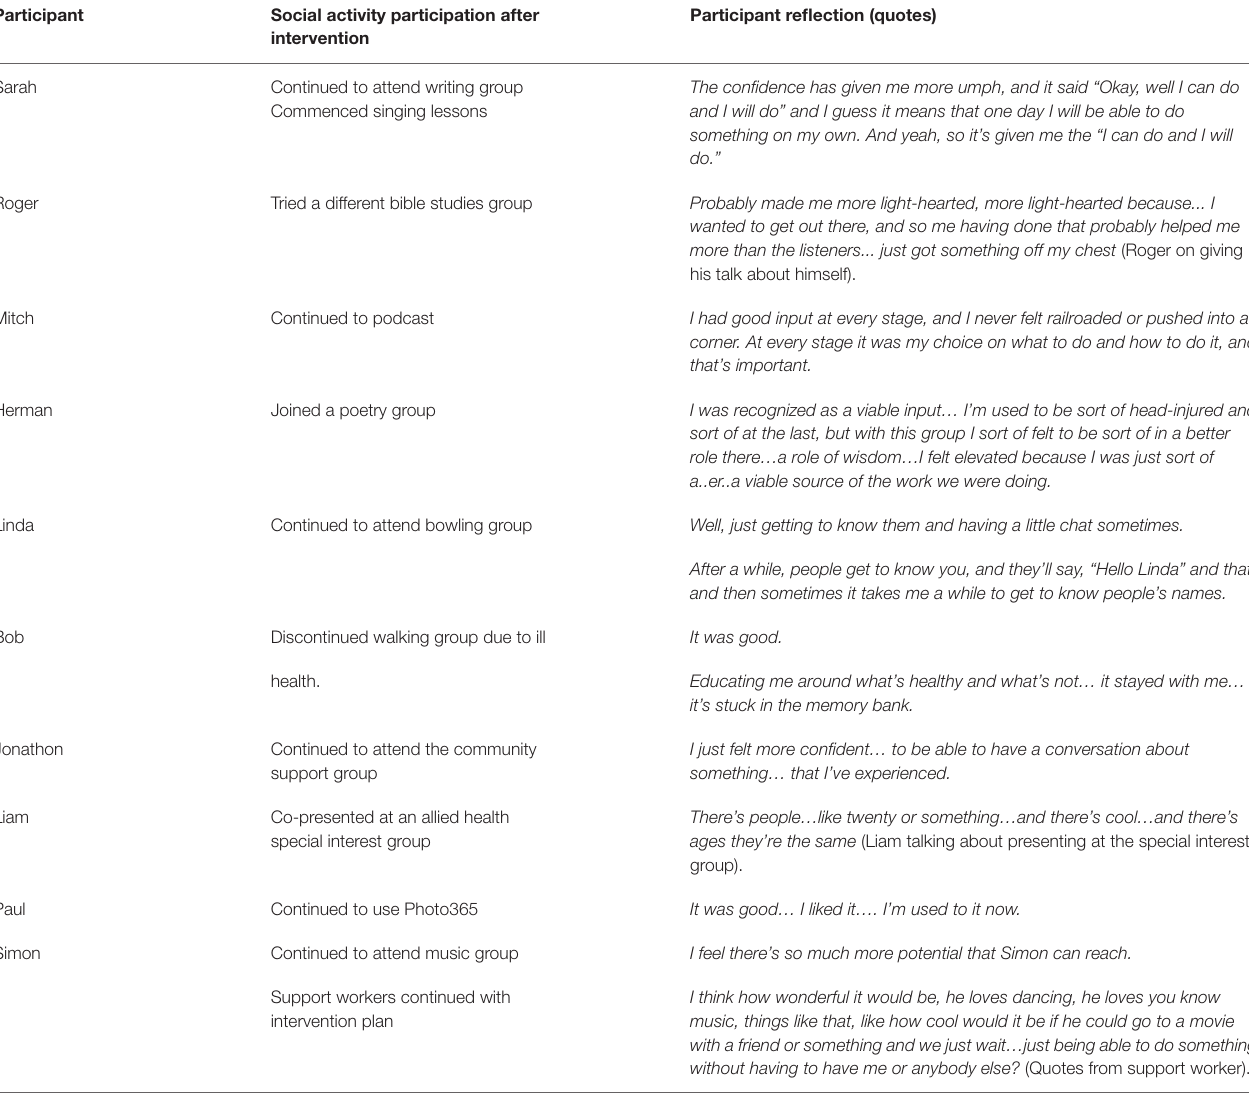
TABLE 4 | Social participation outcomes for participants in the M-ComConnect program (phase